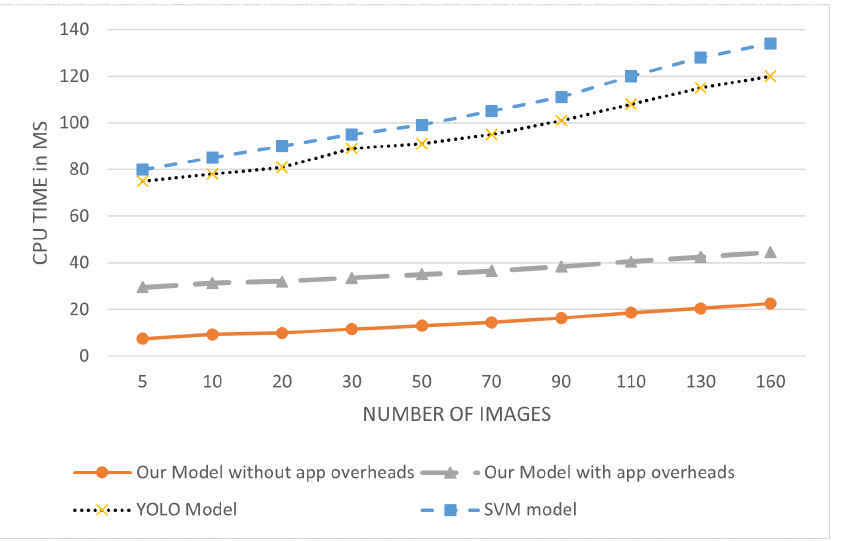
Figure 10. The CPU processing time of our model compared to some existing models such as SVM and